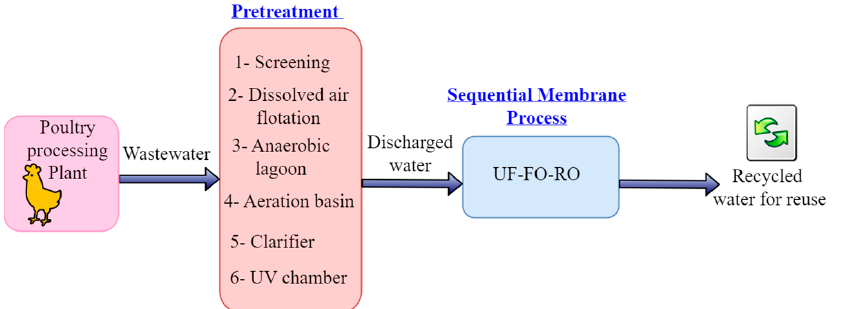
Figure 1. Block flow diagram of the entire process of PSWW